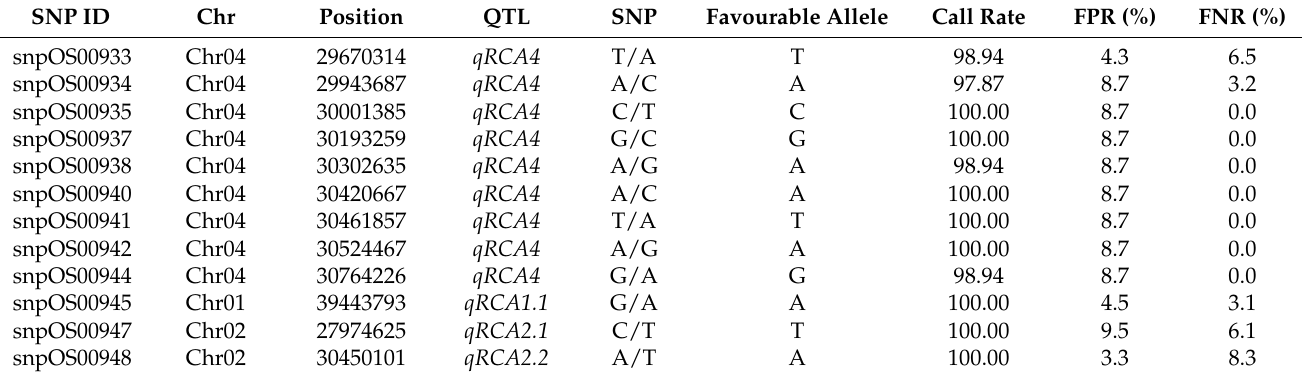
Table 2. Molecular marker quality metrics of newly developed KASP-based SNP markers targeting qRCA